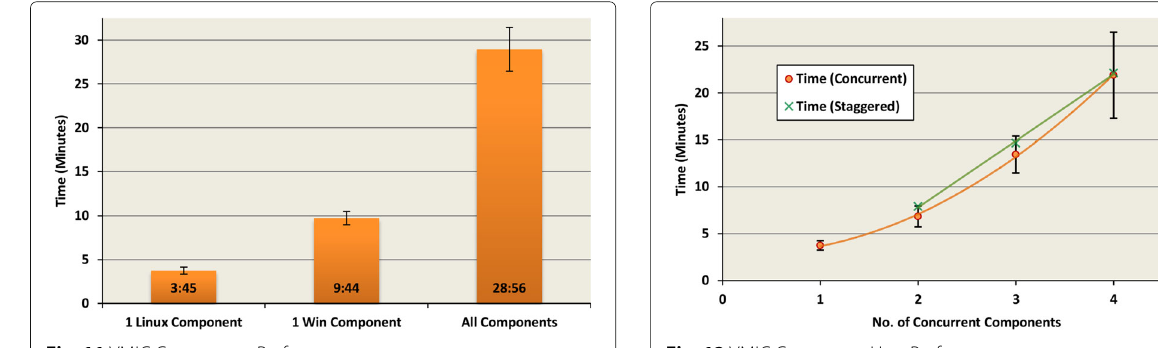
Fig. 12 VMIC Concurrent User